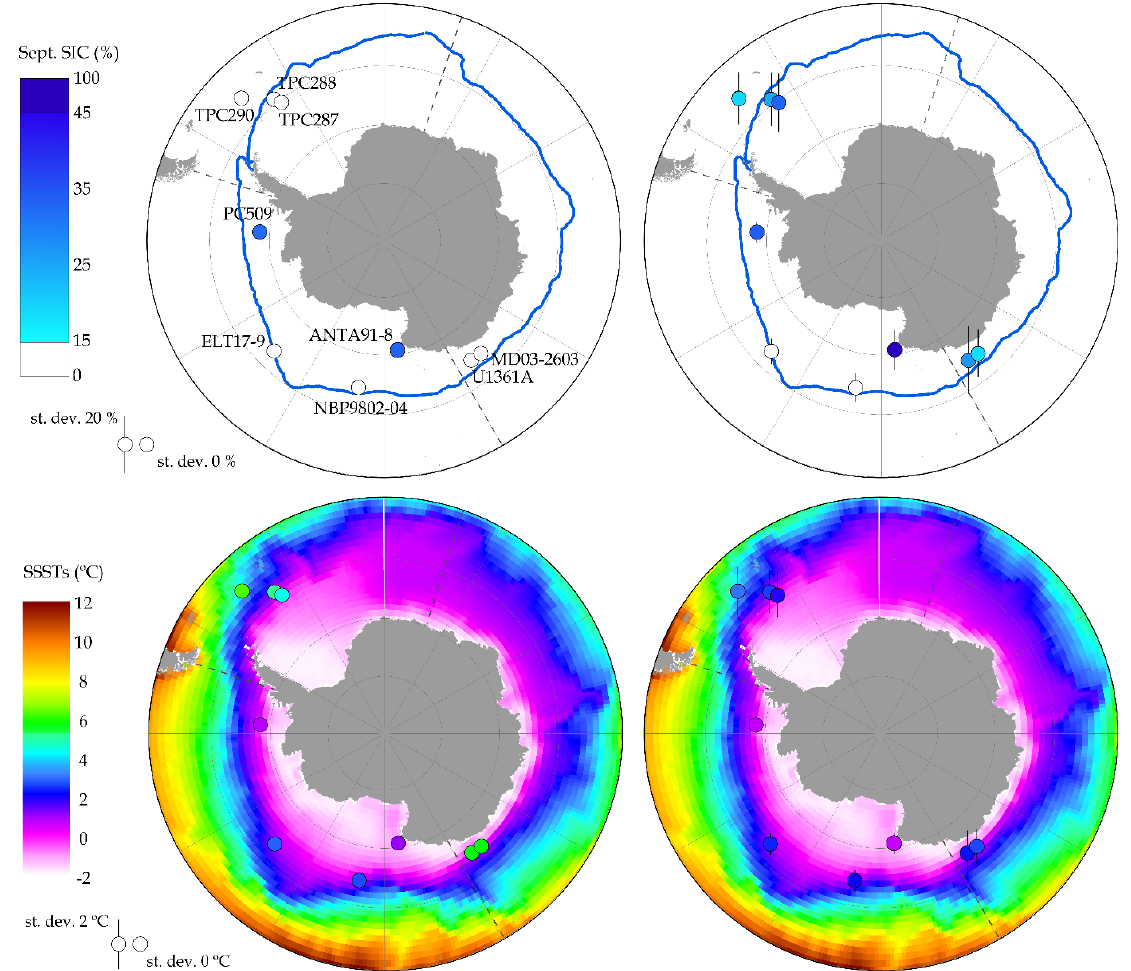
Figure 5. Maps of MIS 5e SSSTs and September SICs for the nine core sites compared with the modern conditions. On all maps the SO sector boundaries are marked with dashed lines. Top left: minimum MIS 5e September SIC for each core site (coloured circles) compared to the modern (1981–2010) 15% September sea-ice extent (blue line) (Fetterer et al., 2017). Top right: average MIS 5e September SICs (coloured circles) and standard deviations (vertical bars) at each core site compared to the modern (1981–2010) 15% September sea-ice extent (blue line) (Fetterer et al., 2017). Bottom left: maximum MIS 5e SSSTs for each core site (coloured circles) compared to modern (January–March, 1980–2019) SSSTs (Hersbach et al., 2019). Bottom right: average MIS 5e SSSTs (coloured circles) and standard deviations (vertical bars) for each core site compared to modern (January–March, 1980–2019) SSSTs (Hersbach et al., 2019). Core data are given in Table